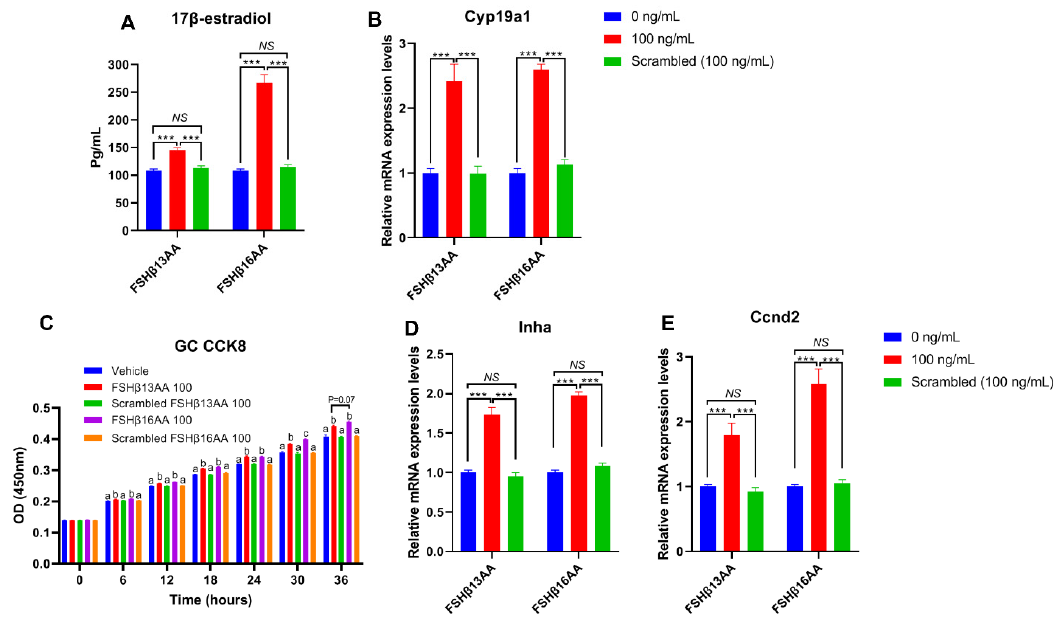
Figure 7. FSH β 13AA/FSH β 16AA promotes the proliferation of the primary murine GCs in vitro. Effects of the dose of FSH β 13AA ( A ) or FSH β 16AA ( B ) on the proliferation of the primary GCs in vitro. * p < 0.05 for comparison of the peptide ‐ treated versus the vehicle ‐ treated (0 ng/mL) by repeated ‐ measures 2 ‐ way ANOVA with Holm–Sidak’s multiple comparisons test. ( C ) FSH β 16AA promoted the proliferation of the primary ovarian GCs in a dose ‐ dependent manner in vitro. a–c Within a treat ‐ ment time point, the means without a common letter differed. ( D , E ) Effects of the dose of FSH β 13AA/FSH β 16AA addition on the mRNA expressions of Ccnd2 and Inh α in GCs. Ccnd2 , cyclin D2; Inha , inhibin α . Data are expressed as mean ± SEM. *** p < 0.001. FSH β 13AA/FSH β 16AA peptides (100 ng/mL) and the vehicle control in promoting the cell proliferation or estrogen production of GCs (Figure 8). To verify that the effects of FSH β 13AA/FSH β 16AA on the reproductive modulation were not due to their size and/or global physico ‐ chemical properties, a mixed scrambled peptide control (Supplemental Table S1) was designed for each peptide. In the experi ‐ ments above, both FSH β 13AA and FSH β 16AA had the highest activities at 100 ng/mL. Compared to FSH β 13AA/FSH β 16AA, 100 ng/mL of the mixed scrambled peptides did not ( p > 0.05) promote the 17 β‐ estradiol production nor the cell proliferation of GCs in vitro (Figure 8). Similarly, there was no difference ( p > 0.05) between the scrambled